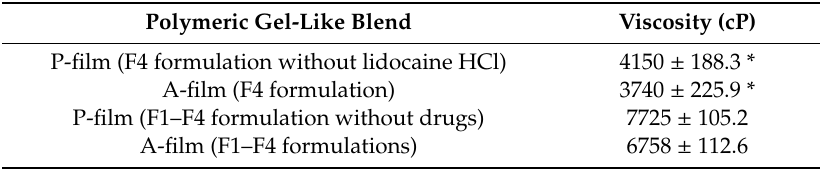
Table 3. Measurements of viscosity of polymeric gel-like blend formulations at 25 ◦ C (M ± SD; n = 3), for P-Films (placebo F4 formulation, F1 and F4 formulations) and A-films (F1 and F4 formulations).